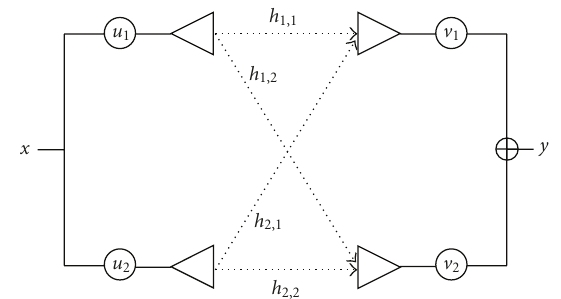
Figure 1: Multiantenna wireless